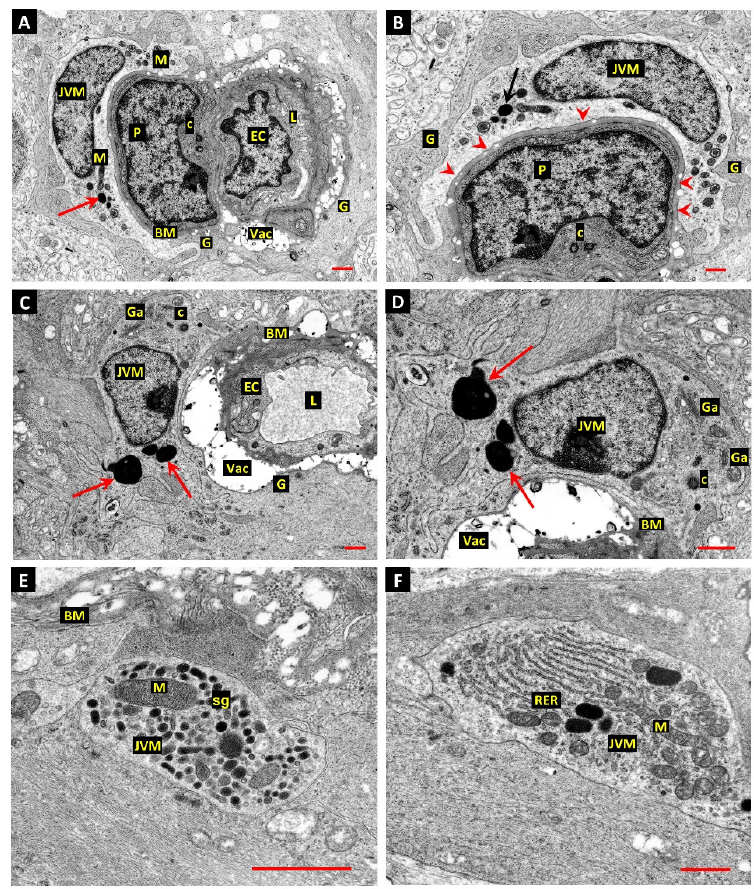
Figure 3. ( A , B ) Normal donor retina shows the nuclei and perinuclear cytoplasm of a JVM in the same profile as a vascular pericyte (P) and endothelial cell (EC). As in the diabetic retina, the cell nucleus of the JVM cell typically lies close to the vascular BM, a feature also seen in the JVM cell shown in panels C , D . The extensive participation of the JVM in the glia limitans is indicated